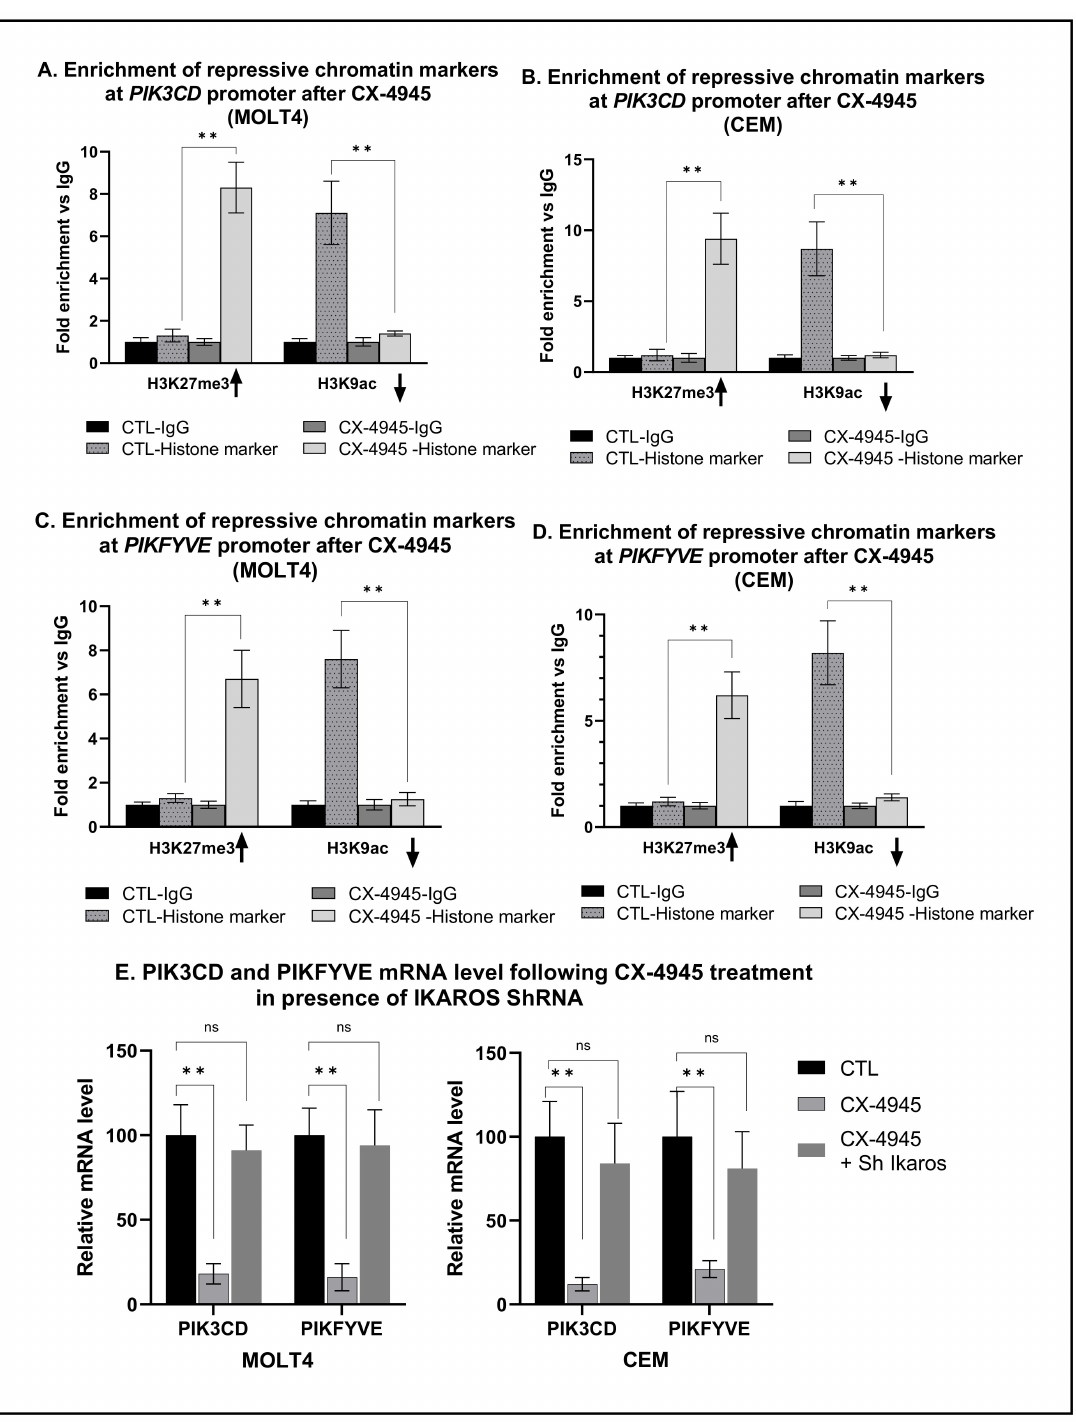
Figure 5. IKAROS regulates the expression of PIK3CD and PIKFYVE by repressive chromatin formation . The qChIP assay showed enrichment of histone markers at PIK3CD ( A , C ) and PIKFYVE ( B , D ) promoters. The qChIP assay was performed using MOLT4 ( A , B ) and CEM ( C , D ) cells (treated with 10 µ M of CX-4945 for 48 h) to determine the fold enrichment of histone markers H3K27me3 and H3K4me3 at PIK3Cd and PIKFYVE promoters compared to control cells. ( E ) MOLT4 and CEM cells were treated with IKZF1 shRNA (shIK) or scrambled shRNA control (shCTL). IKAROS- knockdown CEM and MOLT4 cells were then treated with 5 µ M of CX-4945 for 48 h. Changes in PIK3CD and PIKFYVE gene expression were measured using qPCR. The p -value summaries are as follows: p < 0.01